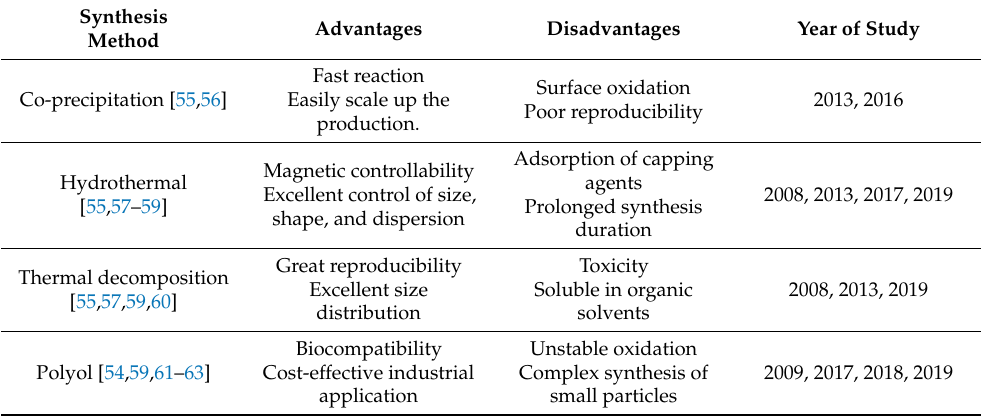
Table 1. Advantages and disadvantages of the most popular methods used to synthesize